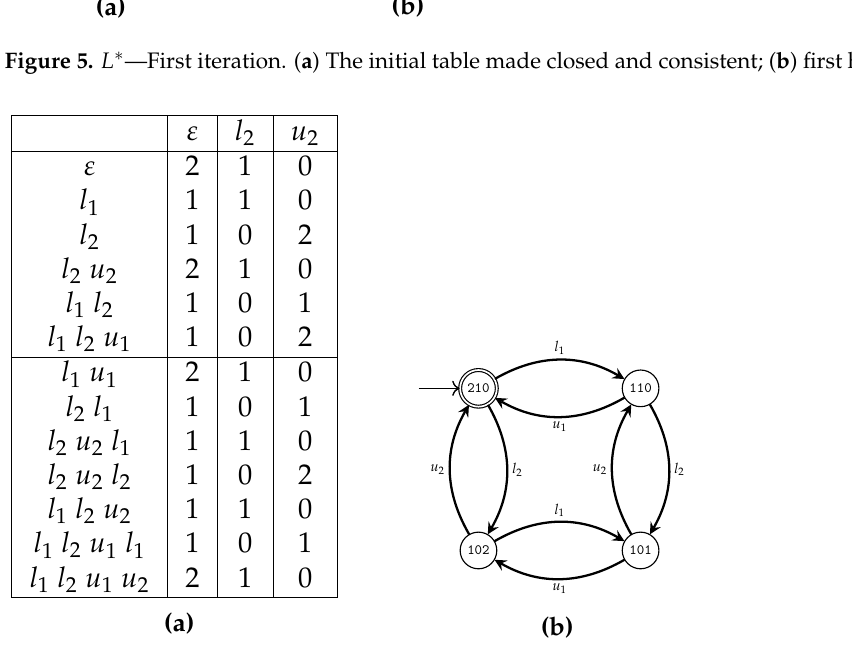
Figure 6. L ∗ – Second Iteration